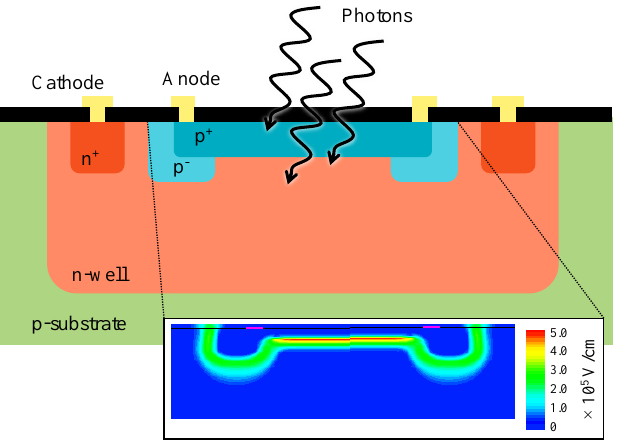
Figure 3. Cross-section of a CMOS SPAD. Shown here is a frontside illuminated p + in n-well SPAD. The inset shows a uniform high electric field region under the whole sensitive area of the SPAD achieved by optimization of the guard-ring geometry and doping